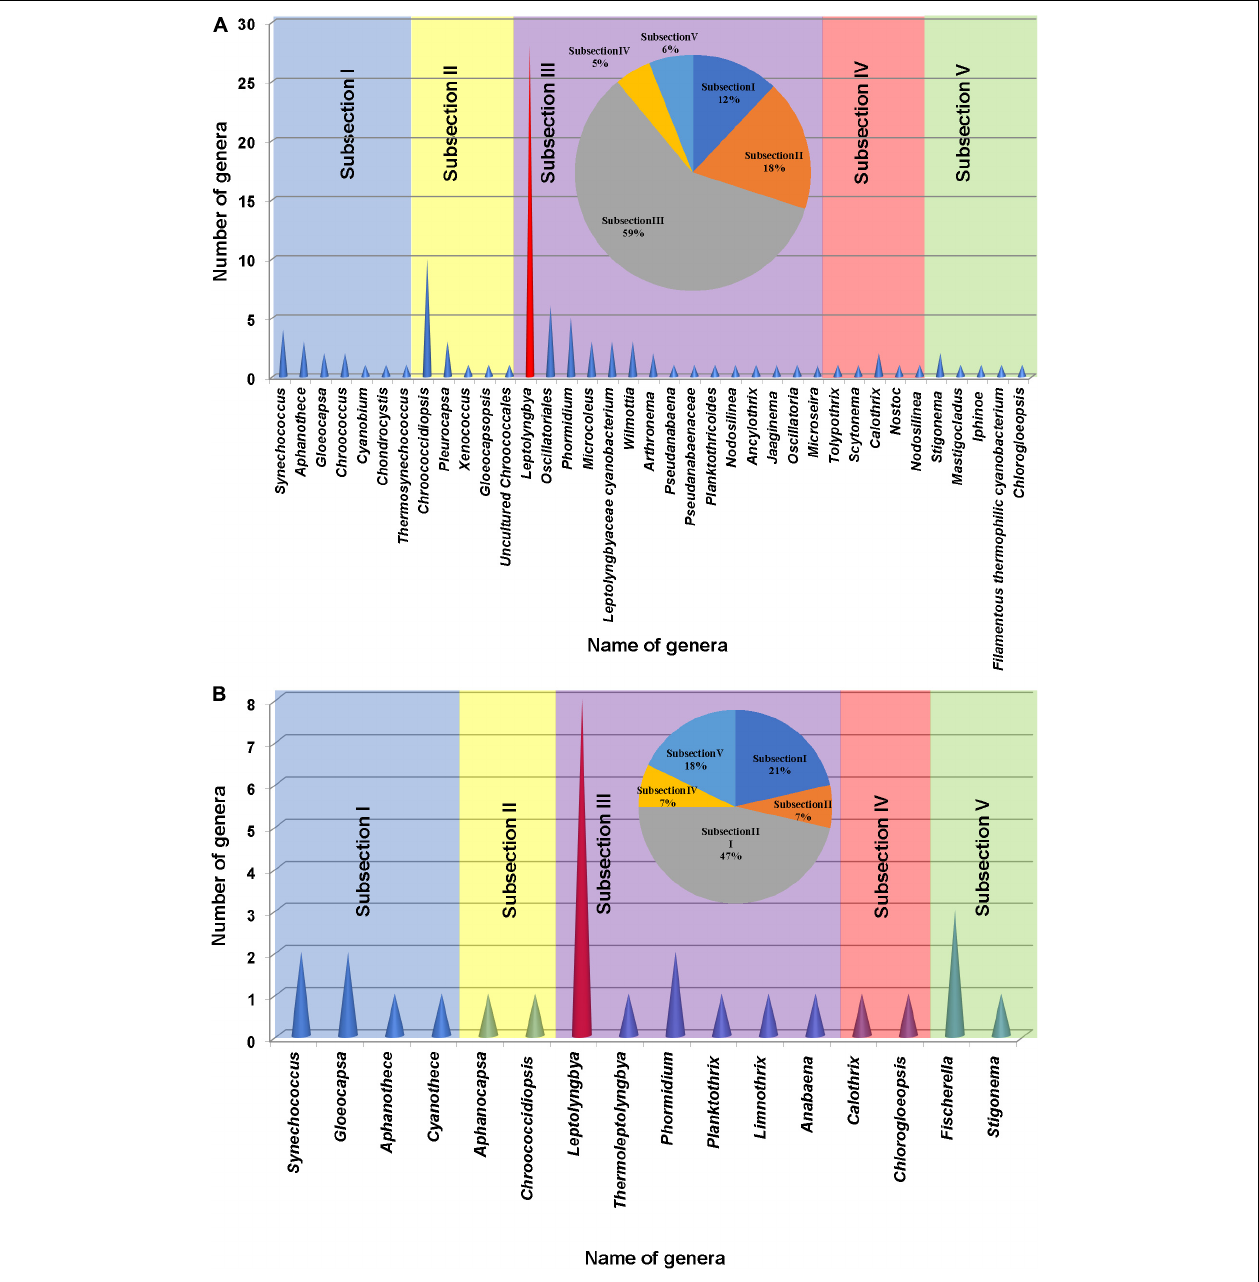
FIGURE 5 | Cyanobacterial genera found based on the 16S rRNA amplicon sequencing analysis (A) and microscopic observation (B) of the samples collected from different studied sites of hot springs/hot water source of China. A pie chart was included in each histogram to display the percentage of cyanobacterial strains based on morphological